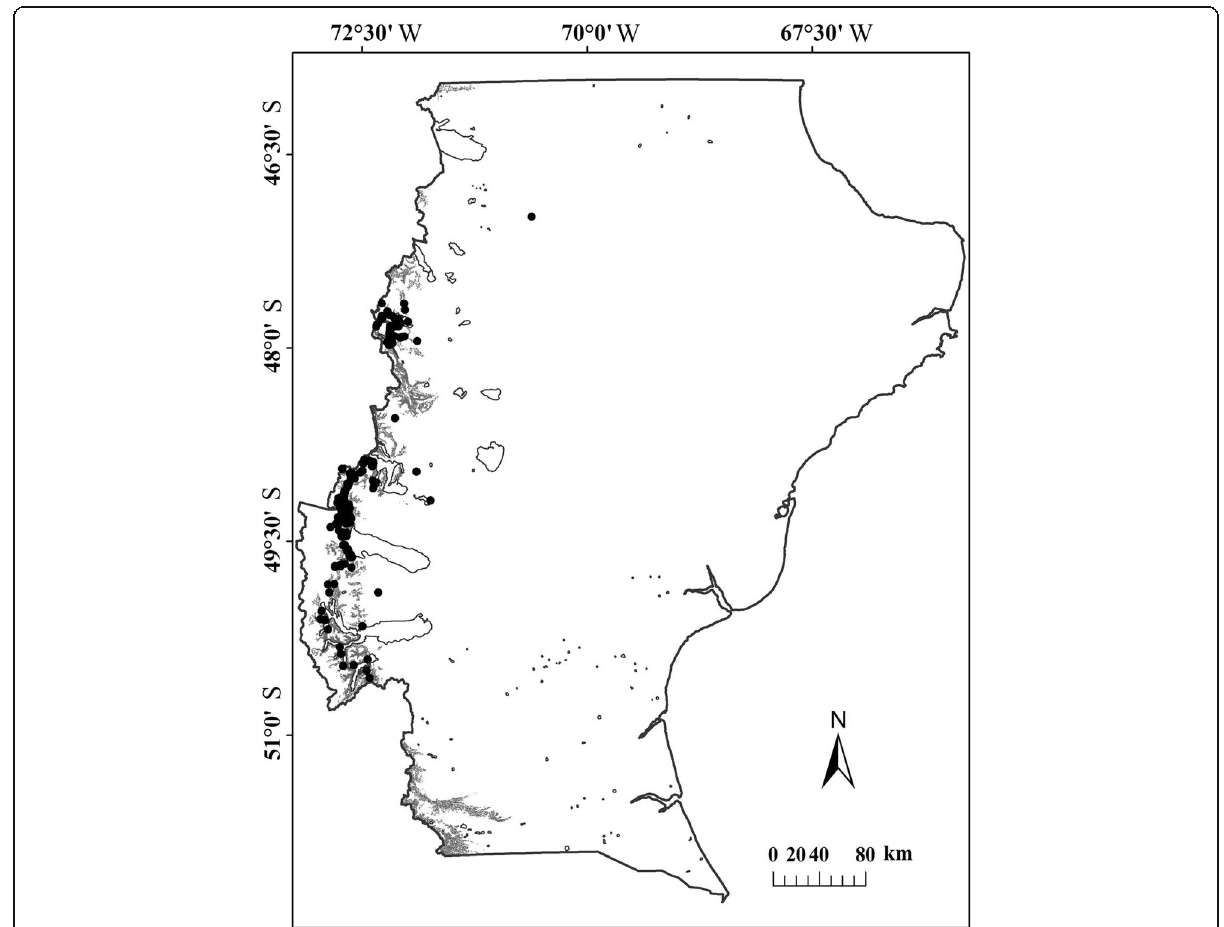
Fig. 4 Comparison between field data ( black dots ) and habitat suitability ( pale gray , 40 – 100%) of huemul in Santa Cruz province